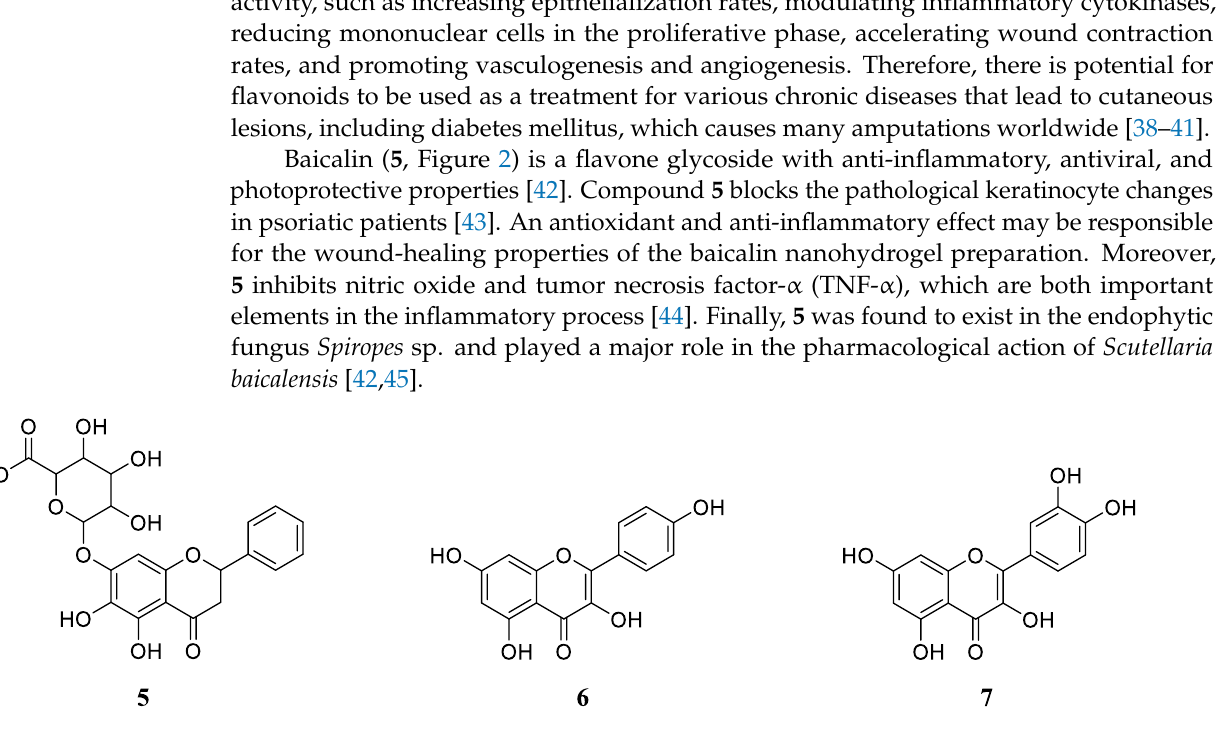
Figure 2. Chemical structures of baicalin ( 5 ), kaempferol ( 6 ), and quercetin ( 7 ) .